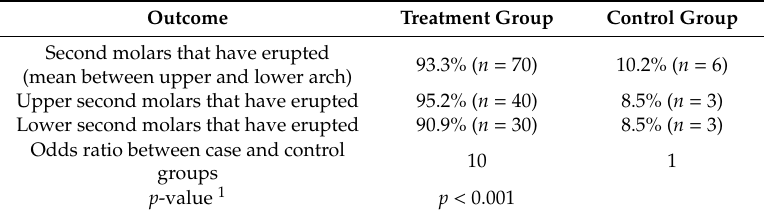
Table 1. Percentages of eruption of the second permanent molars, in the treatment group and in the control group.